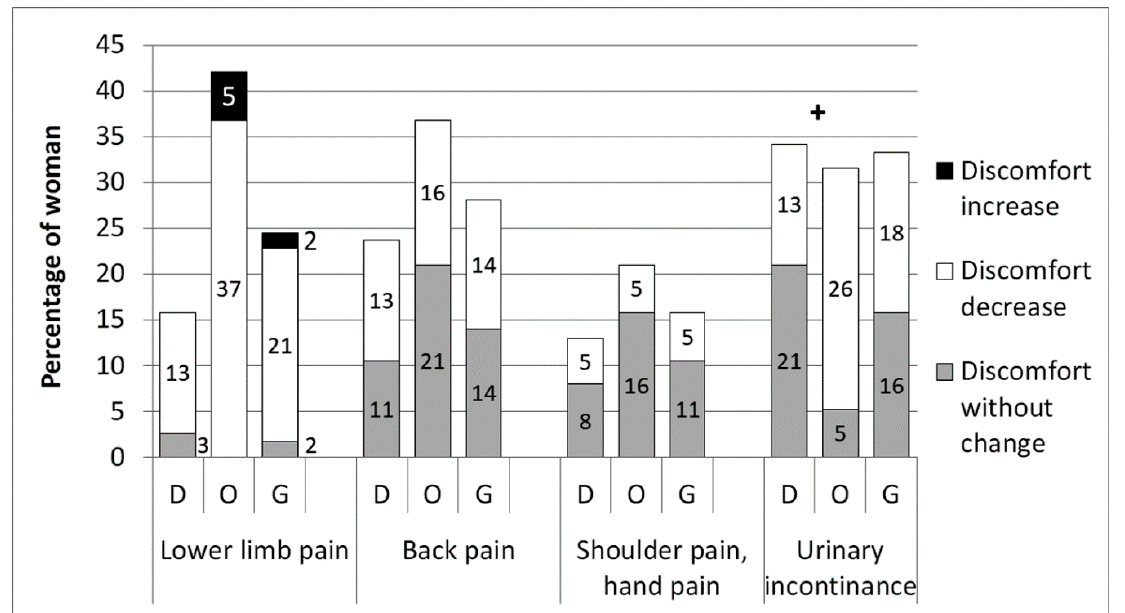
Figure 5. Percentage of women declaring different effects of SR-WBV training on pain syndromes and urinary incontinence in the D program (N = 38), O program (N = 19), and G (the entire group of women) (altogether, N = 57); + p = 0.068.